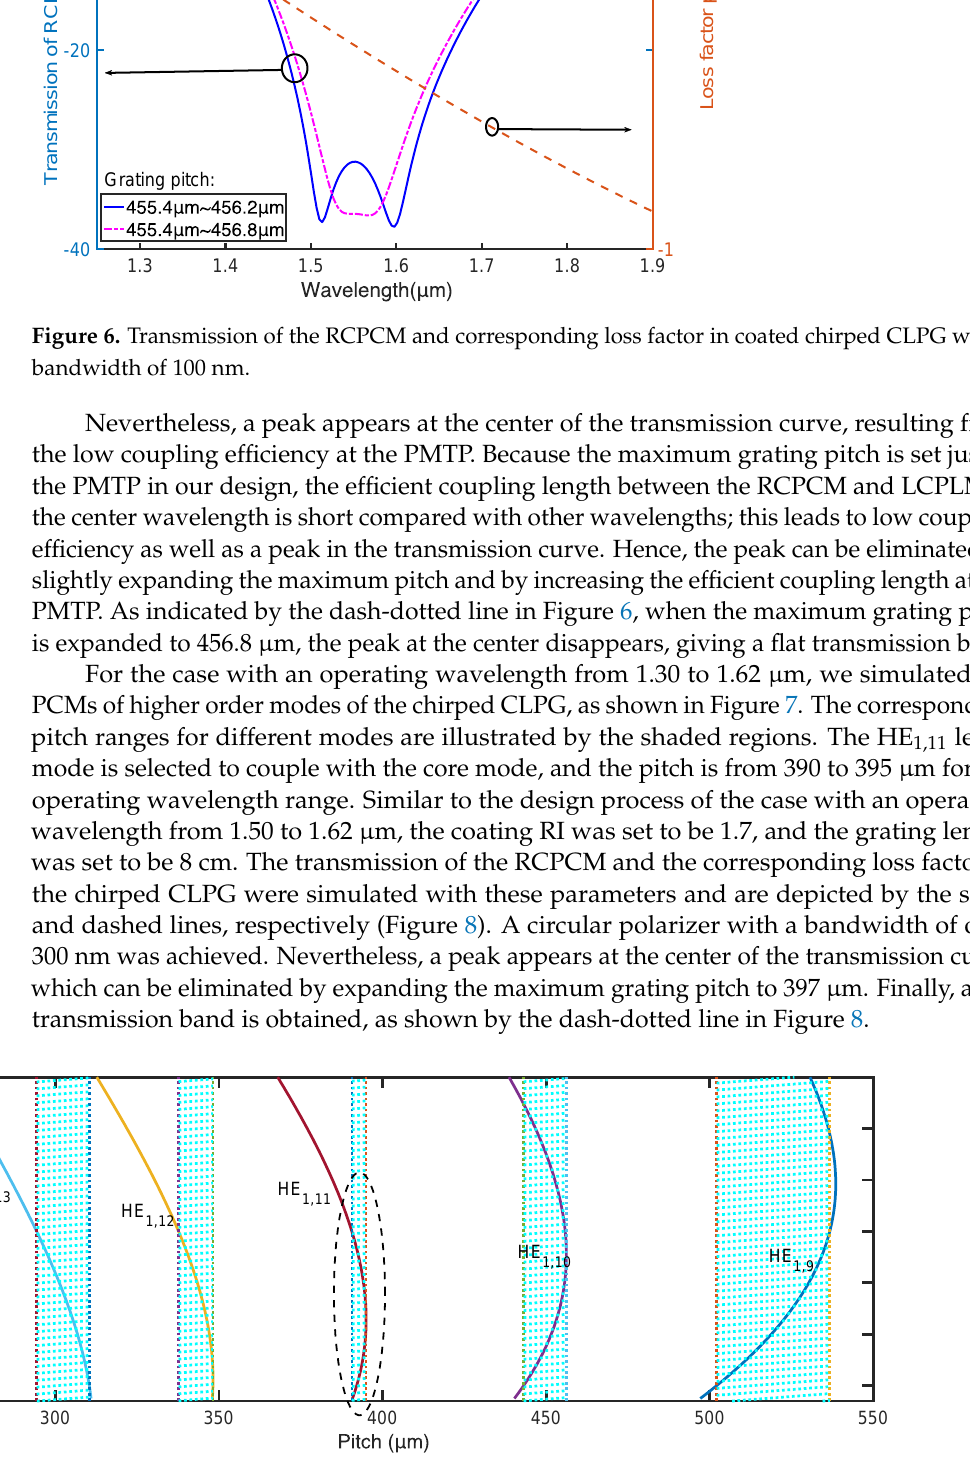
Figure 8. Transmission of RCPCM and corresponding loss factor in coated chirped CLPG. 4. Conclusions A broadband circular polarizer based on a coated chirped CLPG was proposed and demonstrated by simulations. The coating RI of the chirped CLPG was chosen to be higher than that of the fiber cladding, enabling the coupling of RCPCM with LCPLM. Because of the leakage of LCPLM, the power coupled to the LCPLM from RCPCM will radiate out of the fiber and cannot be recoupled back to the RCPCM, which is desired for a high extinc- tion ratio. The coupling mechanism between RCPCM and LCPLM was analyzed with complex coupled-mode theory, and the condition under which the RCPCM decays the most quickly was identified. Moreover, the PMTP was used in the design, which resolved the conflict between the operating bandwidth and the grating pitch range of the chirped CLPG and made a large bandwidth with a small grating pitch possible. The proposed design scheme efficiently combines the leaky mode coupling and PMTP. Using the design scheme, two broadband circular polarizers with an extinction ratio of over 25 dB were demonstrated for various applications: one with a bandwidth of